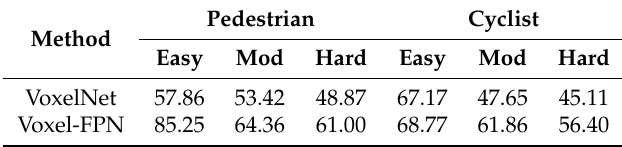
Table 3. 3D detection performances of pedestrians and cyclists (IoU =